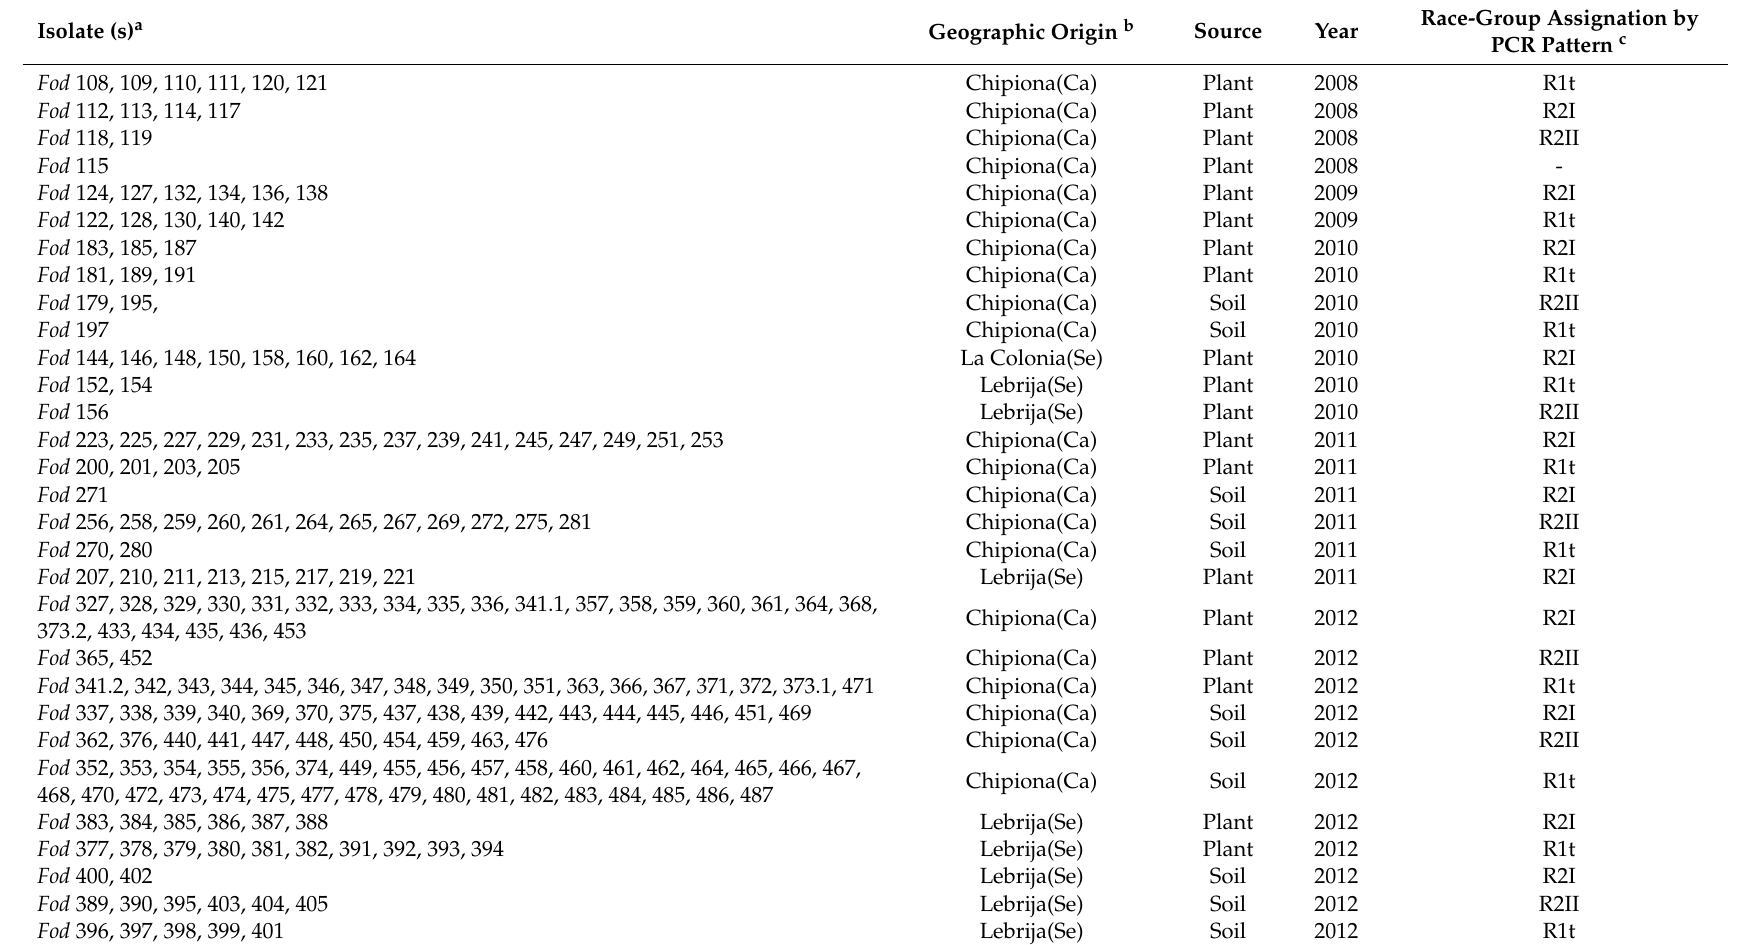
Table 1. Fusarium oxysporum f. sp. dianthi isolates analyzed for the detection of viral